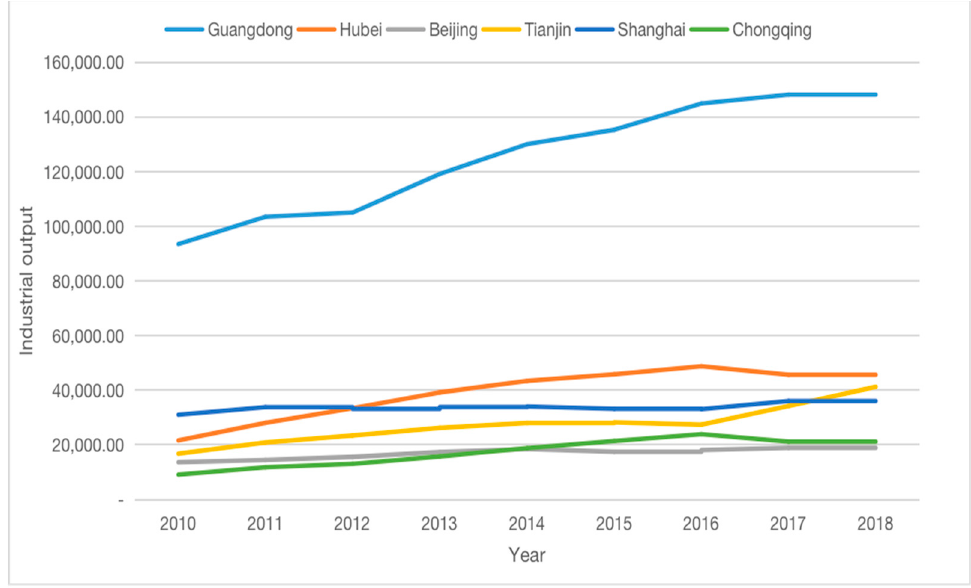
Figure 3. Industrial output value of the pilot regions and provinces from 2010–2018.